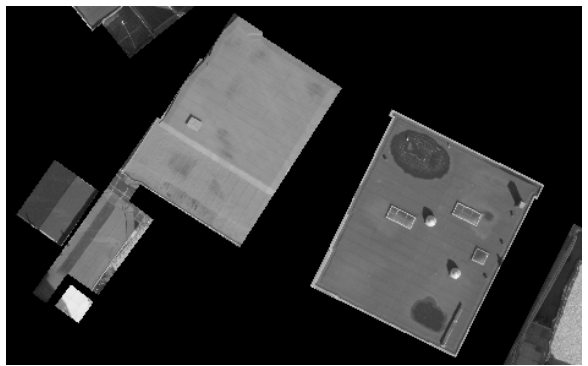
Figure 6: Roofs (detail)